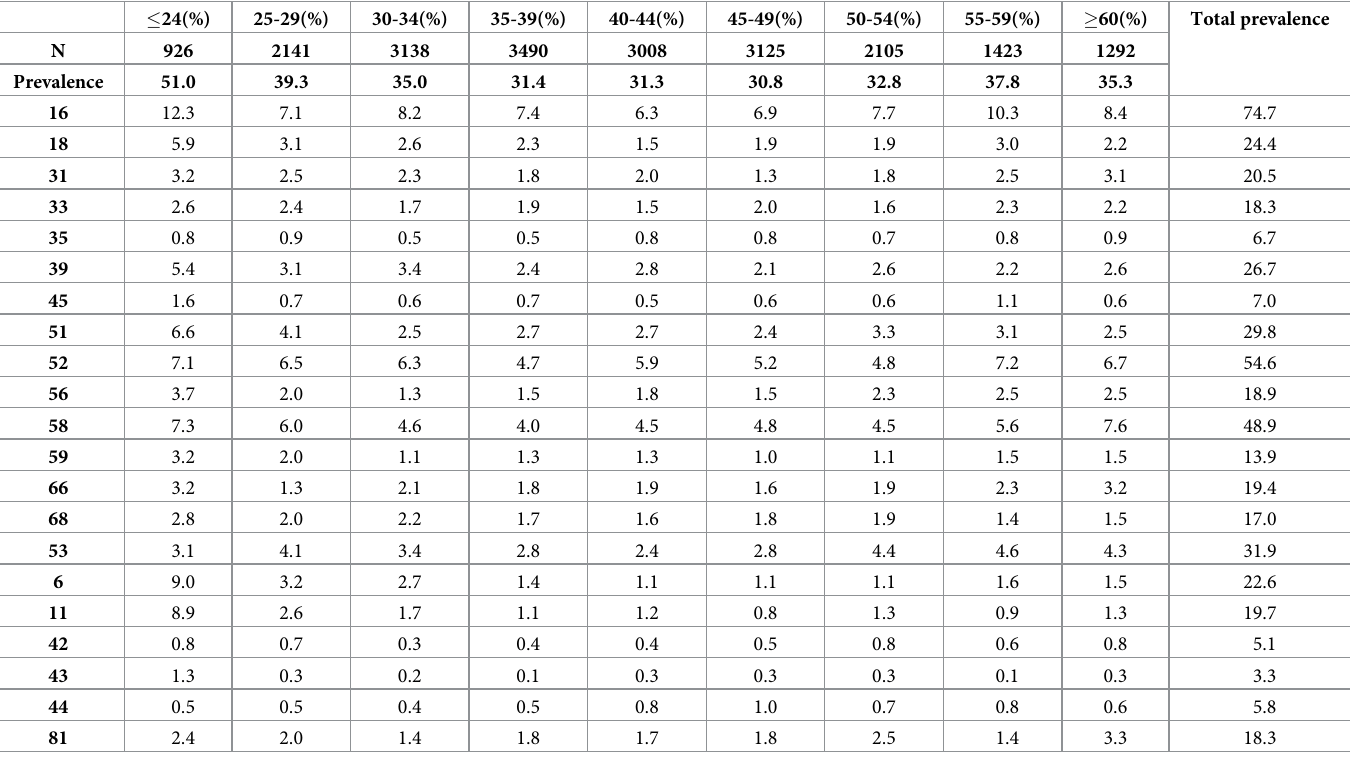
Table 1. Overall age-related HPV prevalence among